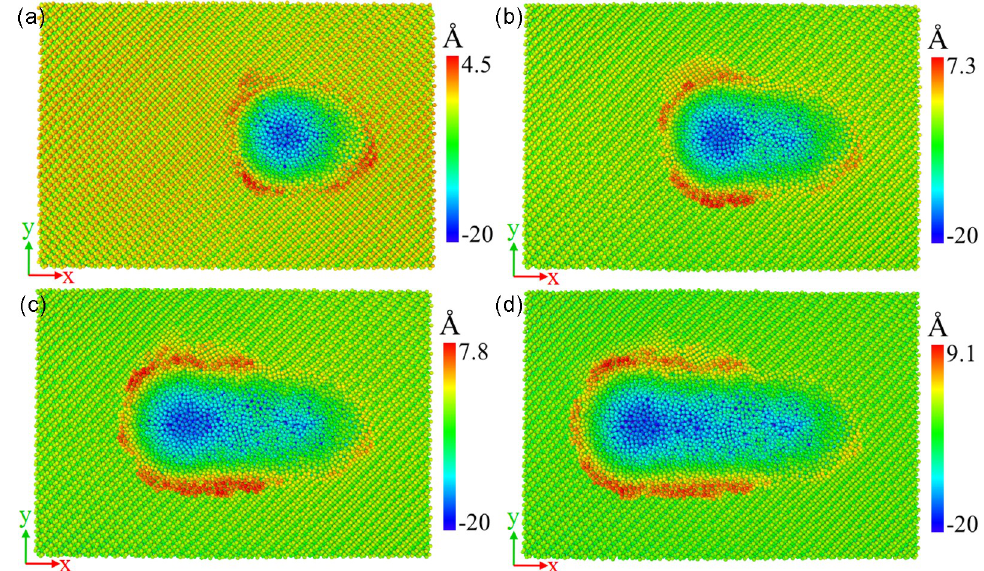
Figure 2. Deformation behaviors of GaAs(001) in scratching at sliding distances of ( a ) 2 nm, ( b ) 5 nm, ( c ) 8 nm, and ( d ) 10 nm. The scratching depth is 1.5 nm. Atoms are colored by heights in z direction.